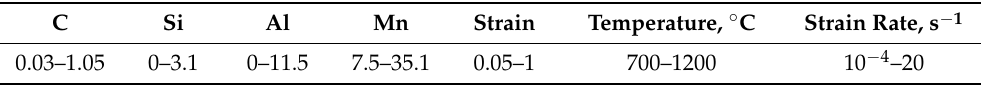
Table 1. The ranges of the C, Si, Mn, and Al content (wt. %) and hot deformation parameters in the